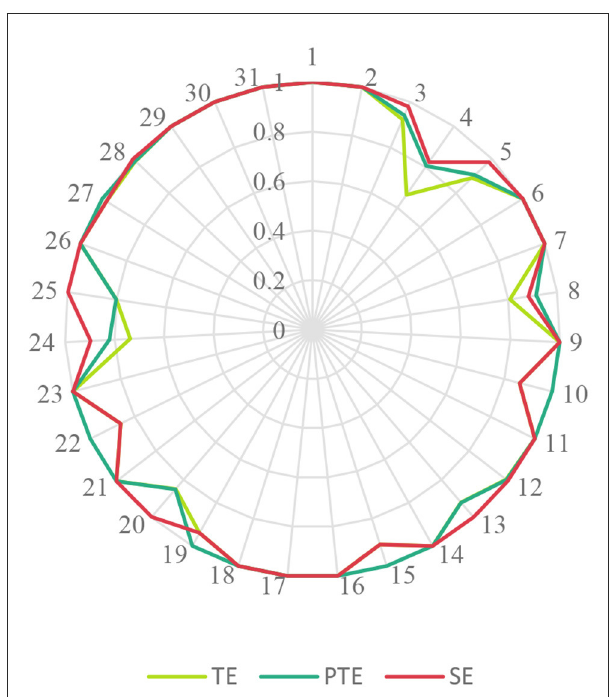
FIGURE2 Distribution of TE, PTE, and SE of LTCFs in all provinces in 2020. TE, technical efficiency; PTE, pure technical efficiency; SE, scale